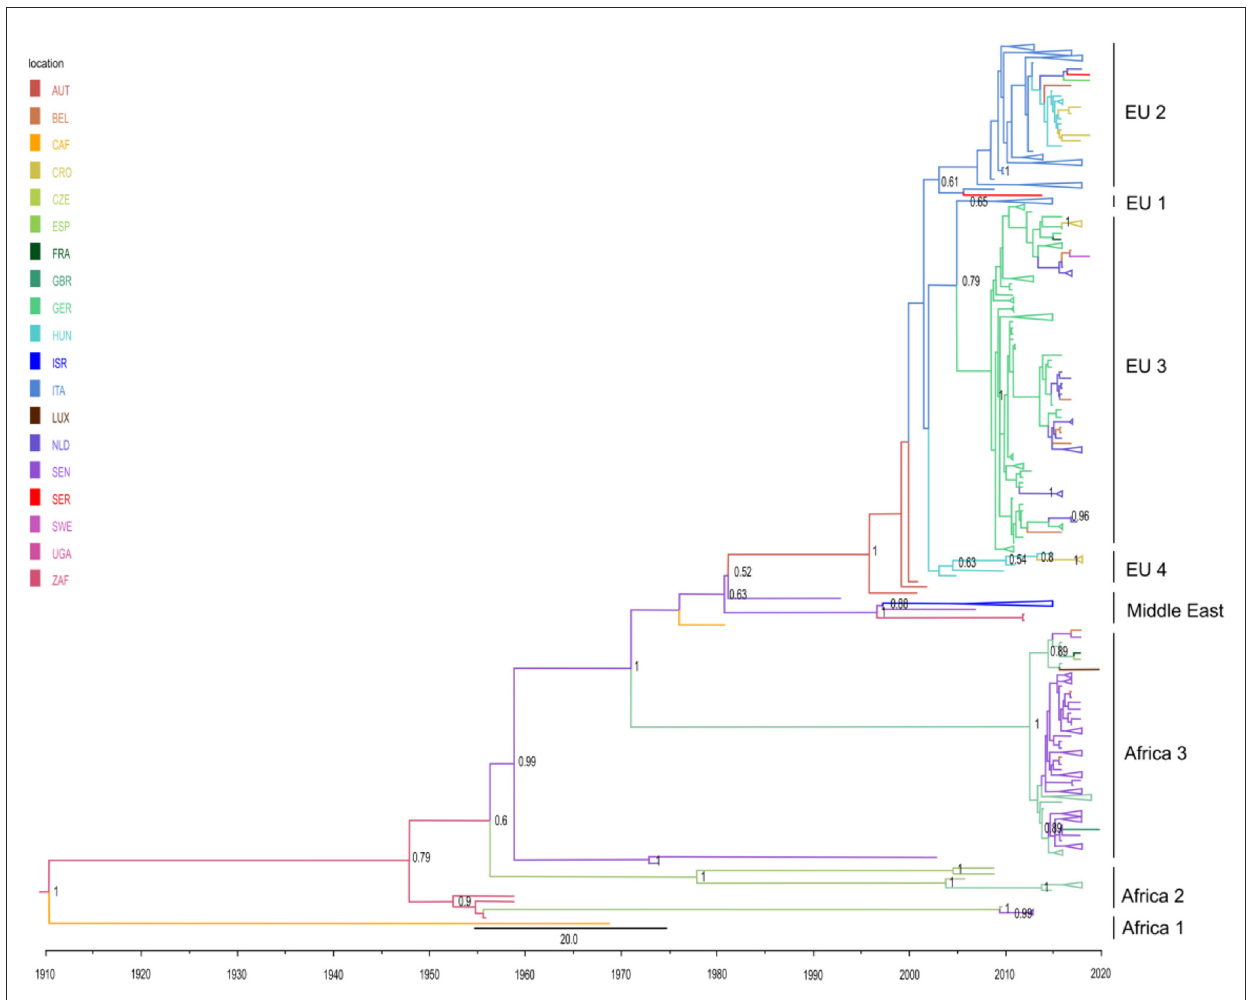
FIGURE2 Phylogeographic analysis of 493 partial NS5 USUV sequences performed in BEAST 1.10.4 software. Maximum clade credibility (MCC) tree was visualized in FigTree 1.4.4. The branches are colored based on the most probable location of the descendent nodes. The numbers on the internal nodes indicate significant posterior probabilities (pp > 0.5), and the scale at the bottom of the tree represents calendar years. All clades with a number of sequences higher than 5 were comprised. Abbreviations: AUT (Austria), BEL (Belgium), CAF (Central African Republic), CRO (Croatia), CZE (Czech Republic), ESP (Spain), FRA (France), GBR (Great Britain), GER (Germany), HUN (Hungary), ISR (Israel), ITA (Italy), LUX (Luxembourg), NLD (The Netherlands), SEN (Senegal), SER (Serbia), SWE (Sweden), UGA (Uganda), ZAF (South